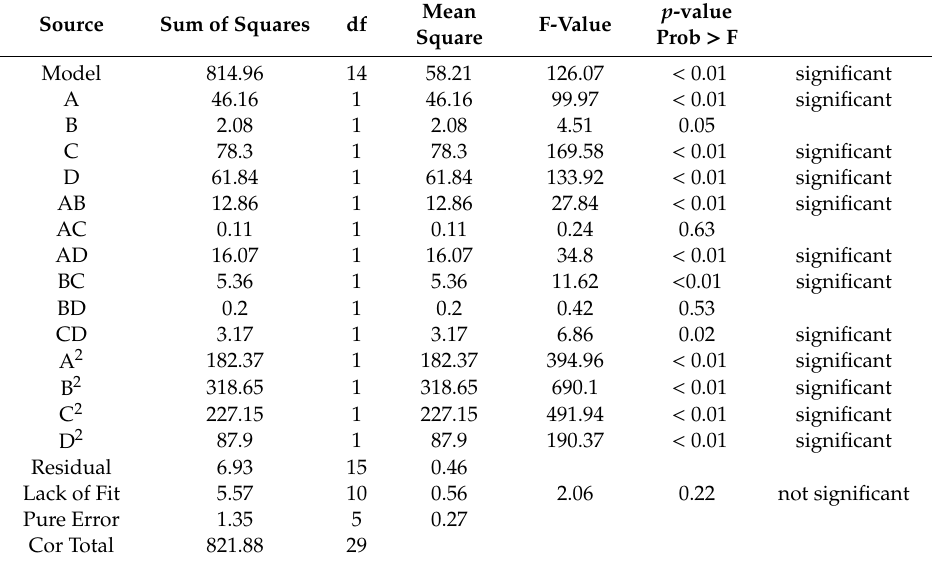
Table 8. ANOVA for quadratic model of tryptophan production by P. acidilactici